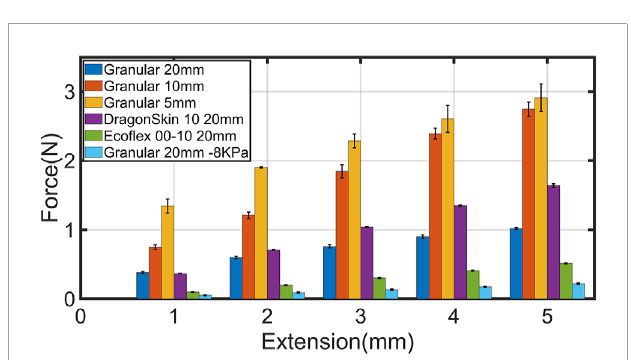
FIGURE 7 The required force to deflect the stalk’s end in various scenarios and the deflection values. The pressure for all scenarios except the last one is −60 KPa. In the last scenario the pressure was set to −8 KPa to measure the bending stiffness of the stalk due to granular particles self jamming before surface attachment. The error bar shows the standard deviation of the measured